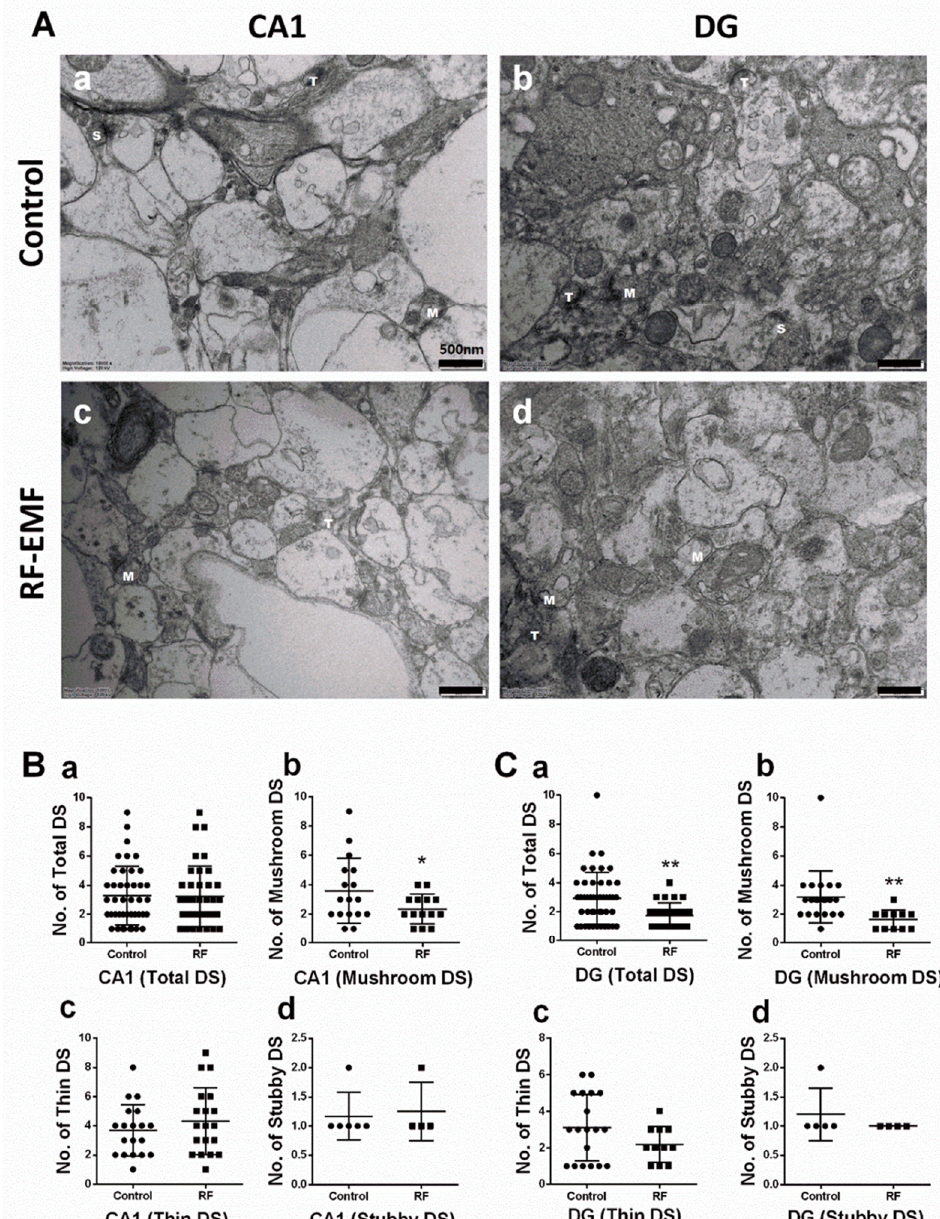
Figure 1. Changes in dendritic spines in hippocampal CA1 and DG of RF-EMF-exposed early postnatal mice. ( A ). Representative TEM images of dendritic spines of hippocampal CA1 ( a , c ) and DG ( b , d ) in control ( a , b ) and RF-EMF-exposed mice ( c , d ). The number of thin ( b ), stubby ( c ), and mushroom-type ( d ) dendritic spines and the total number of dendritic spines ( a ) were analyzed in hippocampal CA1 ( B ) and DG ( C ). Data are expressed as means ± SD. Statistical significance was evaluated using the Student’s t -test. * p < 0.05, ** p < 0.01 vs. control (control n = 4 mice, RF-EMF n = 4 mice). M, mushroom; T, thin; S, Stubby; ● Control; ■ RF-EMF. Scale bars = 500 nm.